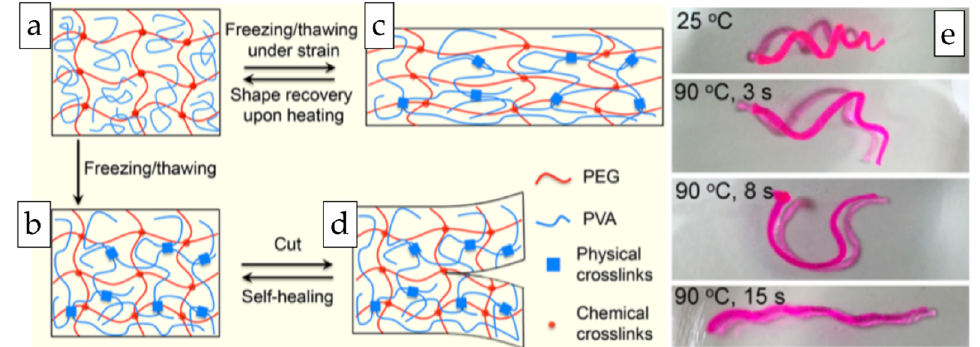
Figure 9. Schematic description of PVA/PEG double-network hydrogels showing both self-shape and self-healing ability ( a ) covalently crosslinked network of PEG mixed with PVA, the “precursor” of the second physical network; ( b ) Using the freezing/thawing treatment, the self-healable double-network hydrogel is produced; ( c , d ) the resultant hydrogel gains shape memory effect when the hydrogel is mechanically strong enough to be processed to a deformed state, followed by the formation of the physical network in the hydrogel under deformation; ( e ) photos showing the fast thermally activated shape recovery of the PVA/PEG hydrogel from a temporary twisted shape to the initial straight state. (Adapted with permission from ref. [195]. Copyright 2015 American Chemical Society).